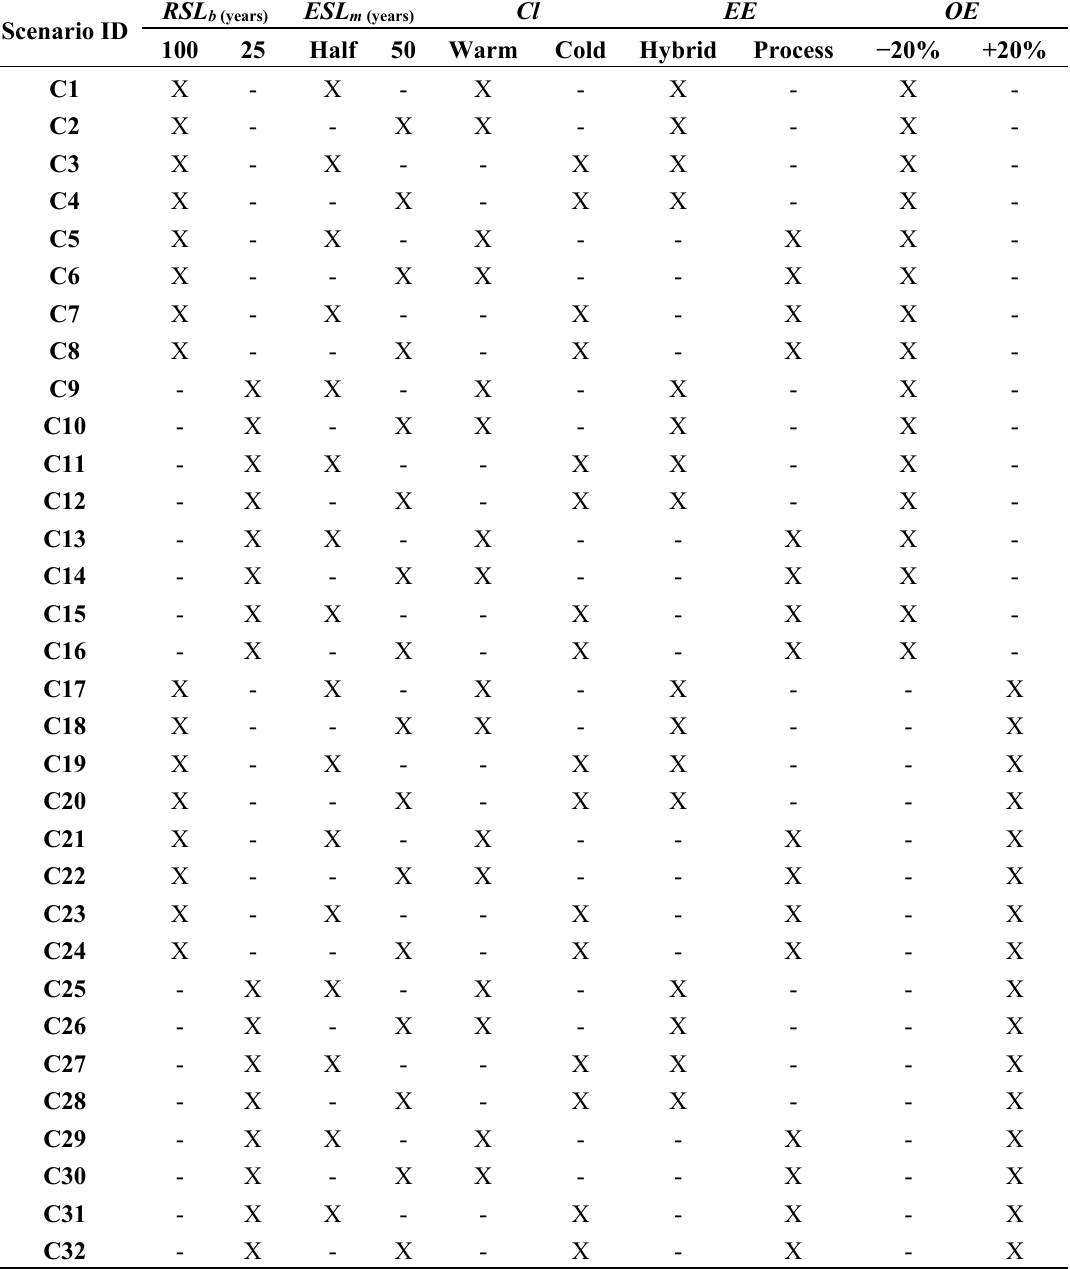
Table 8. Definition of new energy refurbishment scenarios by the combination of different Reference Service Life of buildings ( RSL b ), Estimated Service Life of material ( ESL m ), Climate zone ( Cl ), type of Embodied Energy data ( EE ) and Operational Energy use uncertainties ( OE